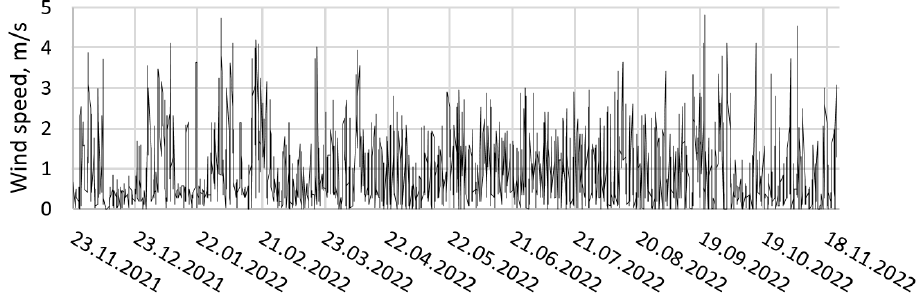
Figure 3. Average wind speed of station ID 23005. One-year datasets.